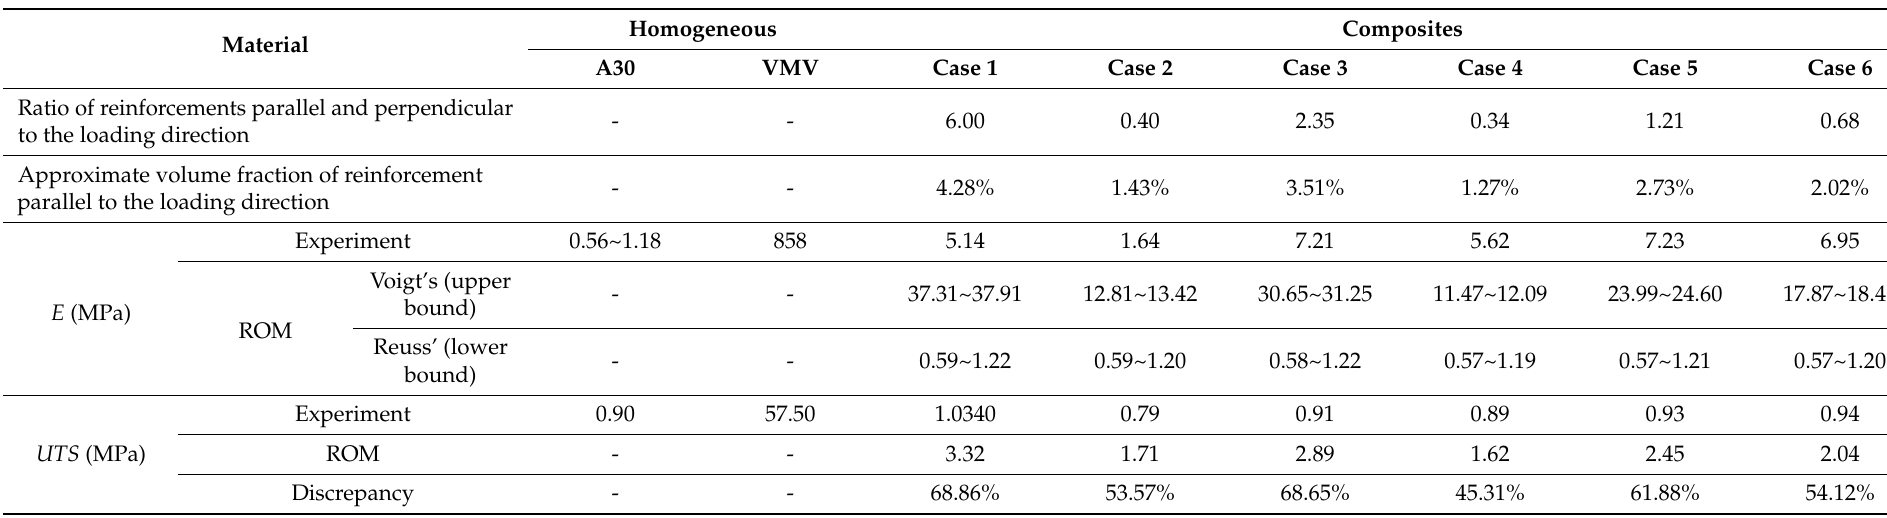
Table 2. Comparisons between experimental results and predictions using the ROM of average elastic modulus and ultimate tensile